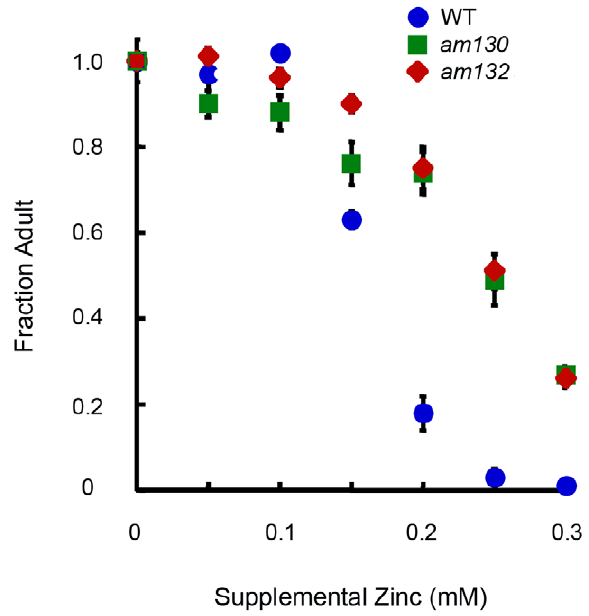
Figure 1. haly-1 mutant animals are resistant to excess dietary zinc. Wild-type, haly-1(am130) and haly-1(am132) hermaphrodites were synchronized at the L1 stage and cultured on NAMM supplemented with zinc (mM). The fraction of worms that grew to adulthood over seven days was monitored; the data were normalized by setting the value at 0 mM supplemental zinc equal to 1.0. Each point indicates mean value 6 SE (n=4 replicates with 50 worms per replicate). The fraction adult for haly-1(am130) and haly-1(am132) was significantly higher than wild type at 0.15 mM and higher concentrations of supplemental zinc (p ,